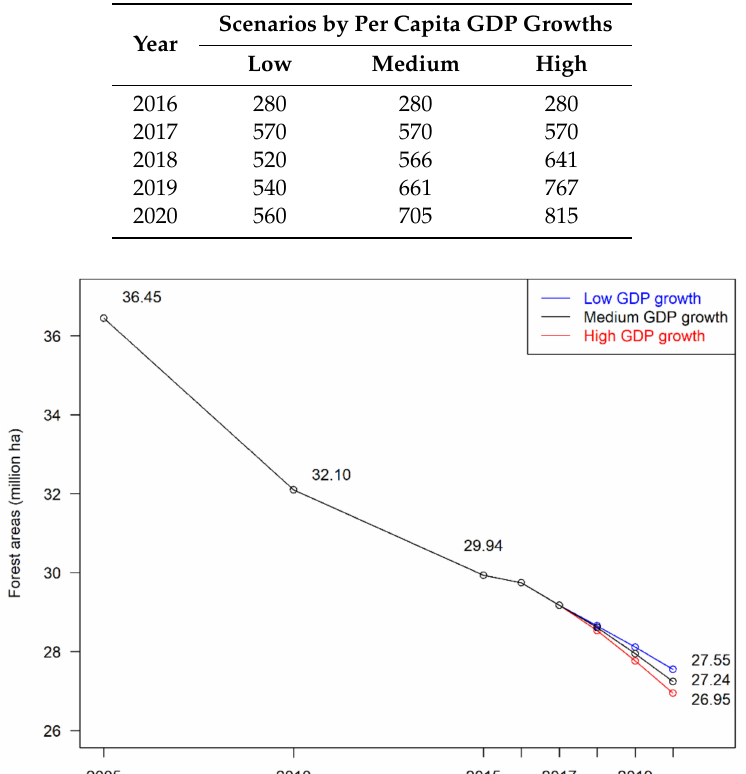
Table 4. Results of forecasting deforestation areas in Myanmar by using medium-level population growth and three scenarios of per capita GDP growth (unit: 1000 ha).